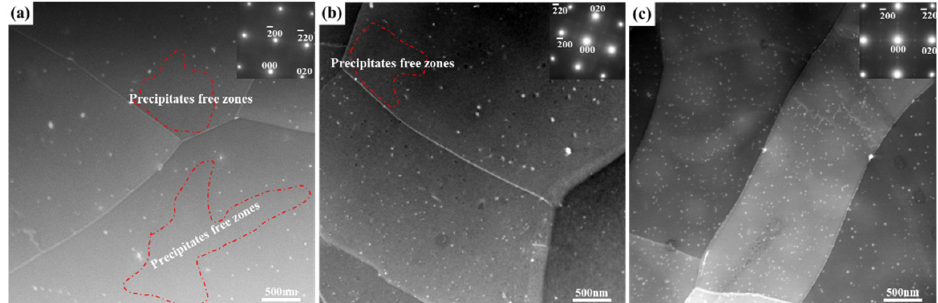
Figure 8. STEM images of Al3Zr distributions in the intragranular and grain boundary of three different homogenized samples: ( a ) AS sample; ( b ) DS sample; ( c ) TDS sample.